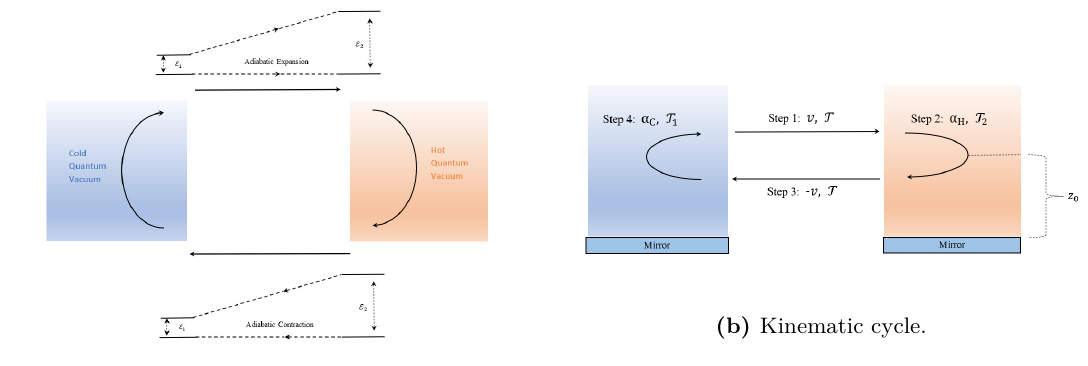
Figure 2. Different cycles of UQOE with a single reflecting